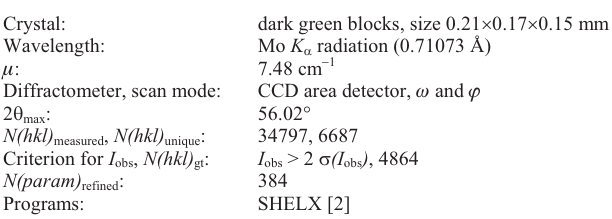
Table 1. Data collection and handling.